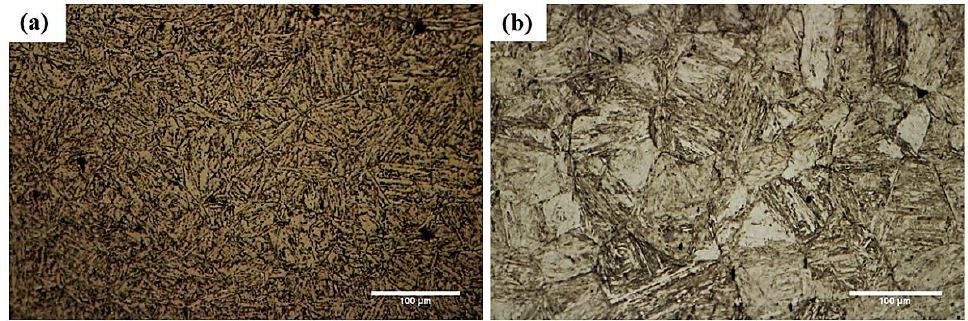
Figure 3. The optical microscopy of the microstructure of martensitic stainless steel410: ( a ) as-received and ( b ) under 1050 °C/60 min conditions.